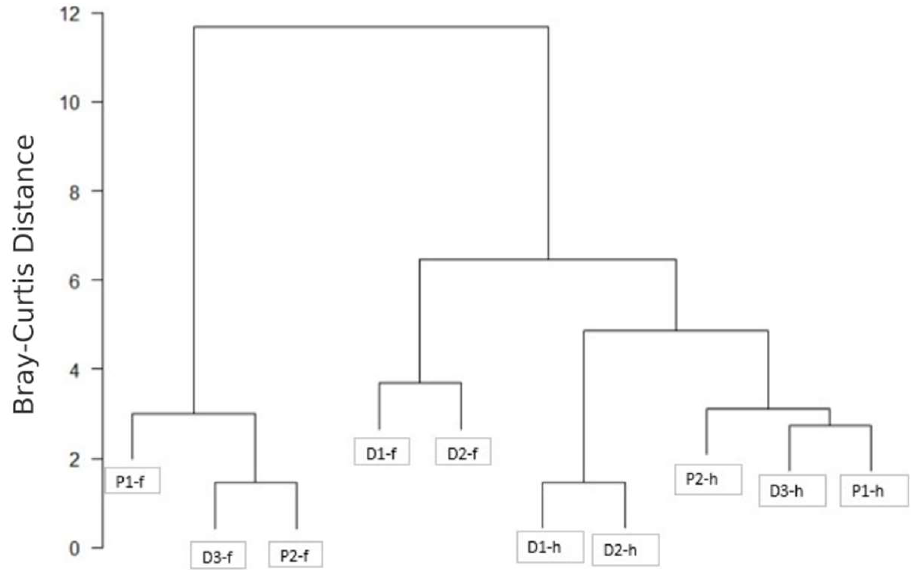
Figure 22. Hierarchical clustering analysis performed over the Bray–Curtis distance matrix between the samples from the UPLC-QTOF-ESI MS results.